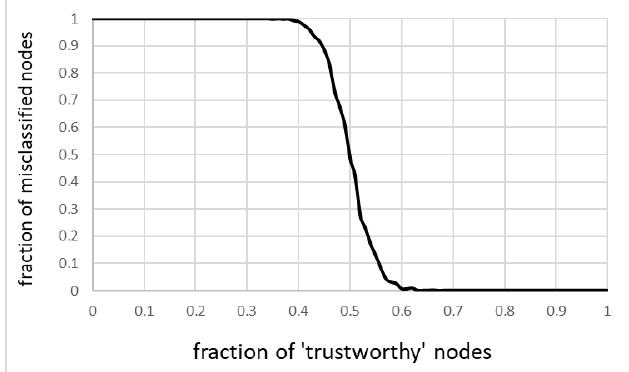
Figure 6. Misclassification as a function of the fraction of trustworthy nodes.